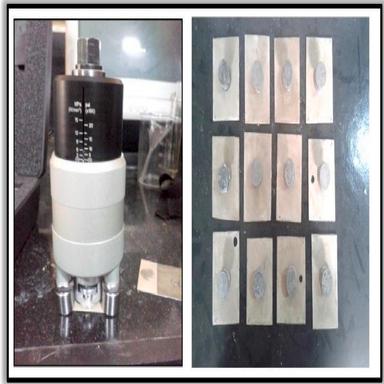
Elcometer 106 and coated coupons for pull-off adhesion test.